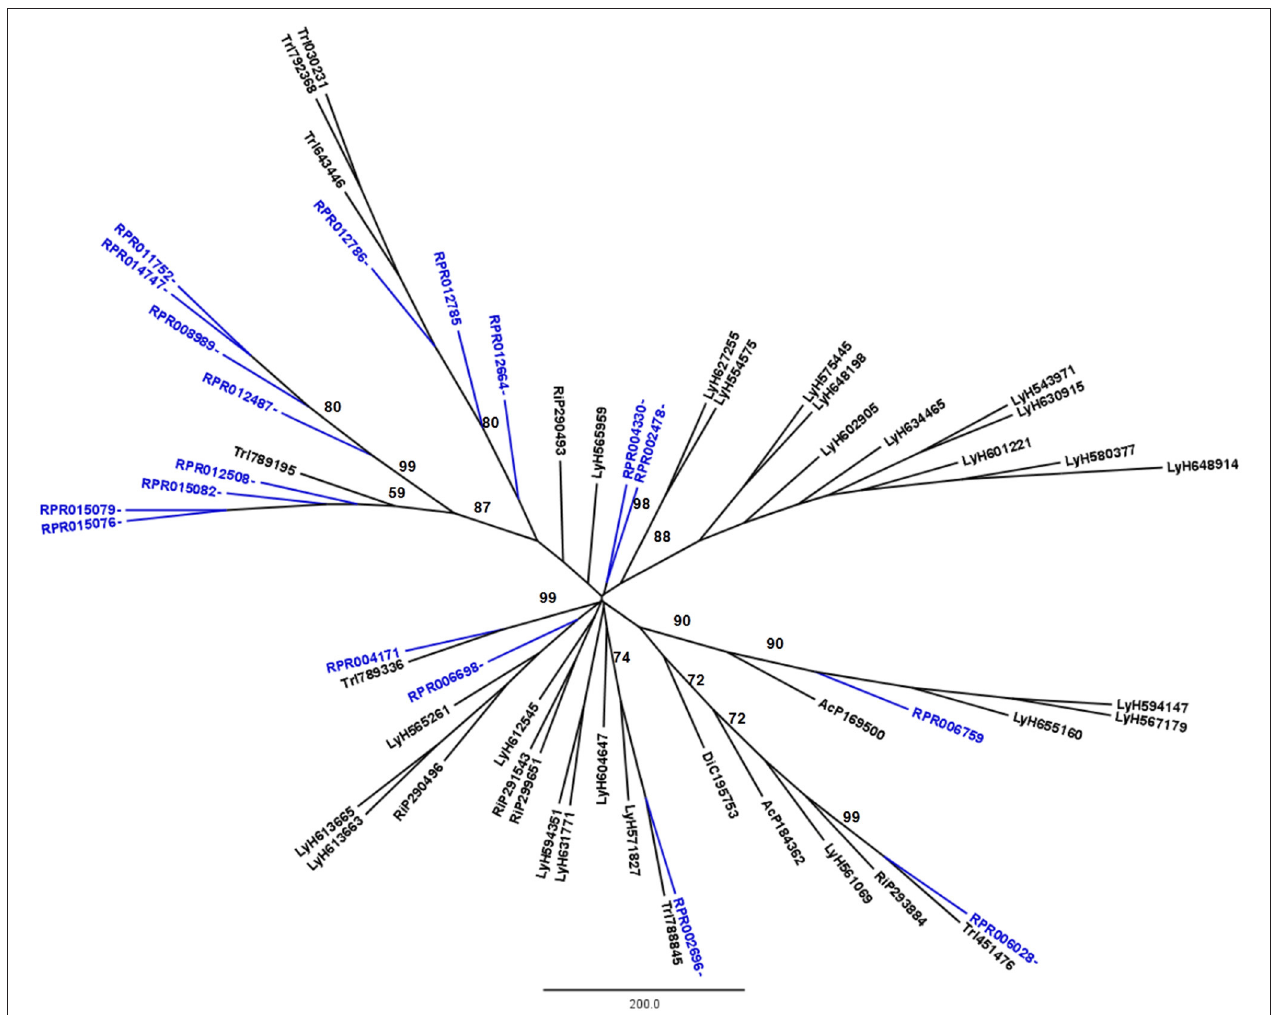
FIGURE 1 | Phylogenetic trees of amino acid sequences from the peptidase family A1 (Pepsin A or Cathepsin D-like proteins) in Hemiptera. Blue, branches with Rhodnius prolixus peptidases (RPR); Black, branches with peptidases from other species; TrI, Triatoma infestans (hemathophagus Heteroptera); LyH, Lygus hesperus (Heteroptera); RiP, Riptortus pedestris (Heteroptera); AcP, Acyrthosiphon pisum (Aphidiformes); DiC, Diaphorina citri (Psylliformes). Basal bootstrap above 50 is shown in the